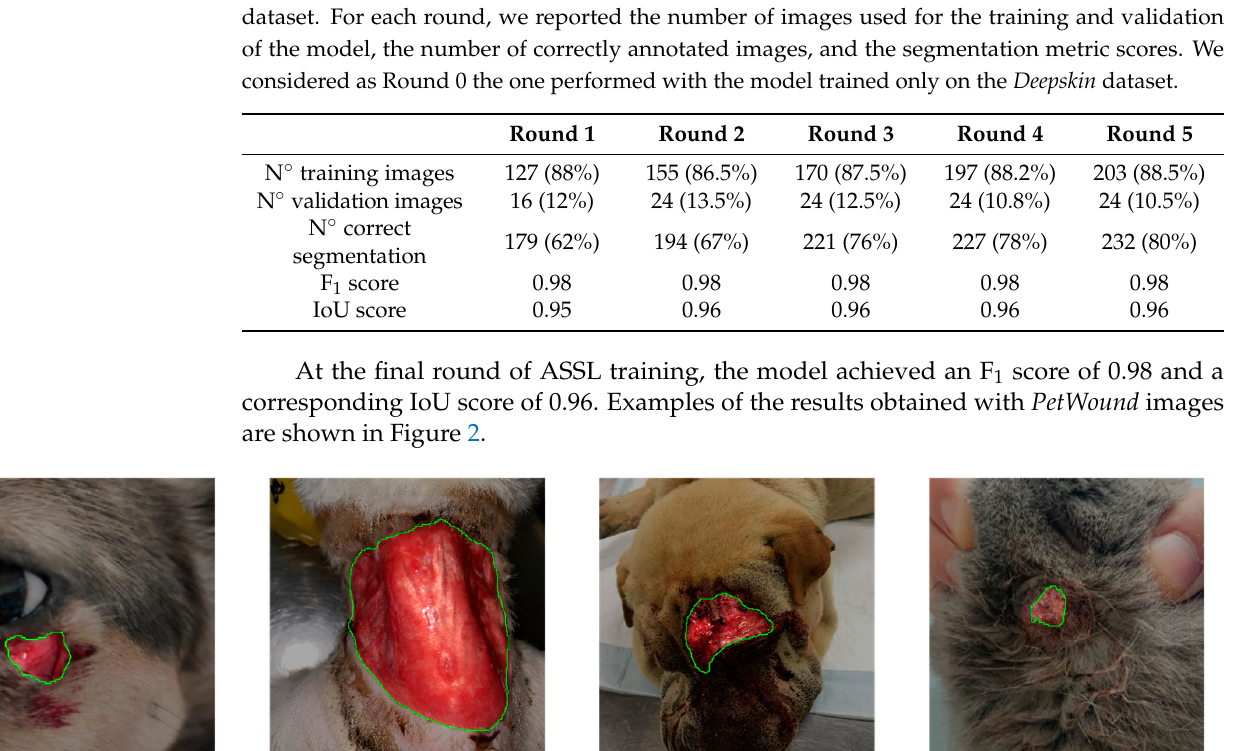
Figure 2. Example of segmentations obtained by the EfficientNet-b3 model at the end of the 5th round of ASSL training. In green, we marked the contours of the segmentation masks produced by the model, highlighting with the alpha level the region of interest identified. The aspect ratio of the images was manually adjusted to be coherent among them.